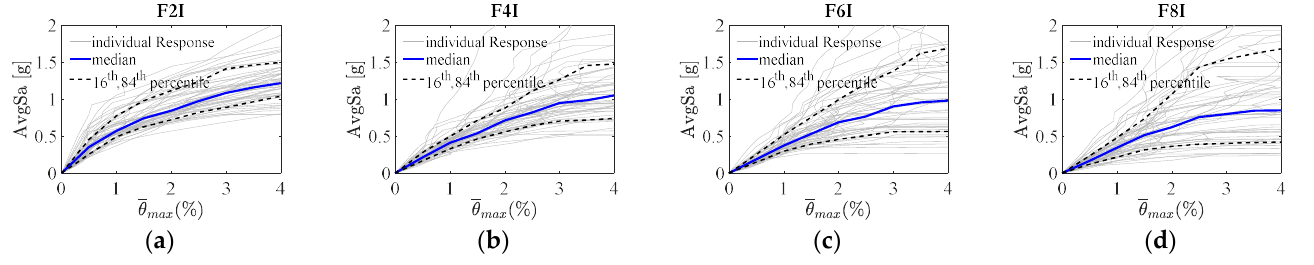
Figure 14. IDA curves obtained for the control case structures: ( a ) structure F2I, ( b ) F4I, ( c ) F6I and ( d ) F8I. The results of the cases shown in Figure 15 also highlight that the several pounding configurations involving floor-to-floor contact between the buildings, either with or without a separation distance, do not exhibit a significantly different performance. On the other hand, when compared to these configurations, those involving floor-to-column contact exhibit a significant number of shear failures. For these configurations, having a larger separation distance between the adjacent structures provides better performance, but the occurrence of shear failures is inevitable for the considered configurations. Since all the structures were only designed for gravity loads, the global failure of a given pounding